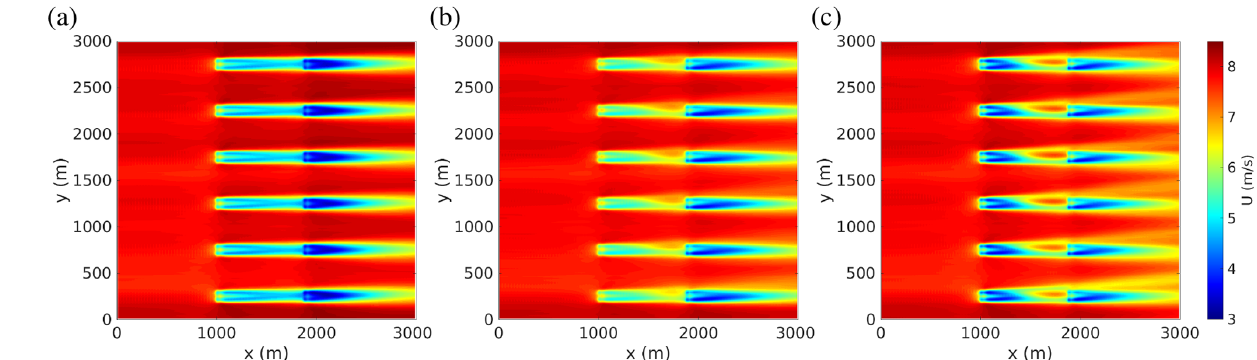
Figure 2. Tilt control: mean (temporally averaged) streamwise velocity field in the horizontal plane at hub height obtained (a) in the baseline case, where all turbines are operated in default mode; (b) with upwind turbines tilted by ϕ = 30 ◦ and operated at the default rotor-collective blade-pitch angle β = 0 ◦ ; and (c) with upwind turbines tilted by ϕ = 30 ◦ and operated at higher induction ( β = − 5 ◦ ). The mean wind is from the west (from the left, parallel to the x axis). Note that the entire 3km × 3km computational domain is shown in the figure and that periodic boundary conditions are applied on the north and south boundaries.